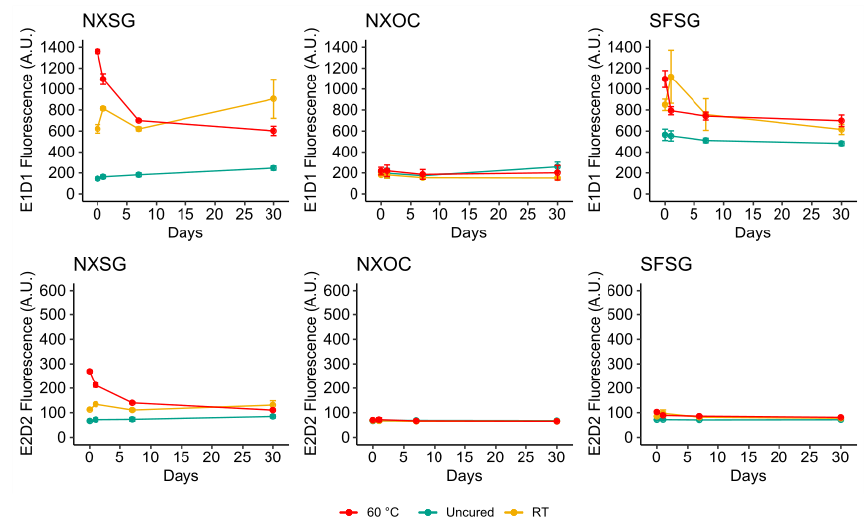
Figure 7. Influence of aging on the background fluorescence of microreactors. All measurements were performed on three microreactors for each material and post curing protocol.